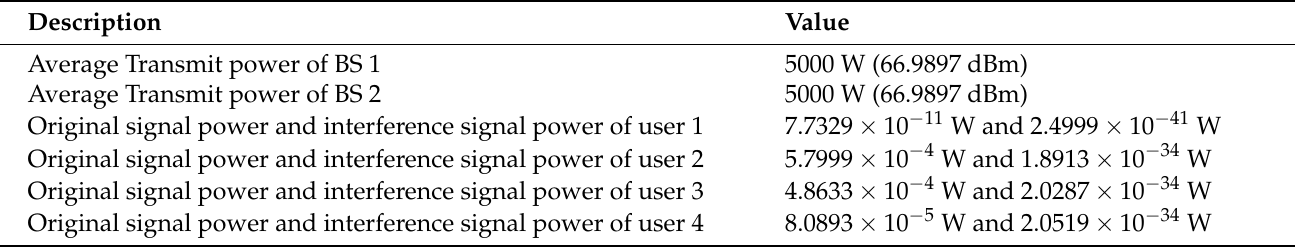
Table 3. Estimated signal power at both the BS and user end.